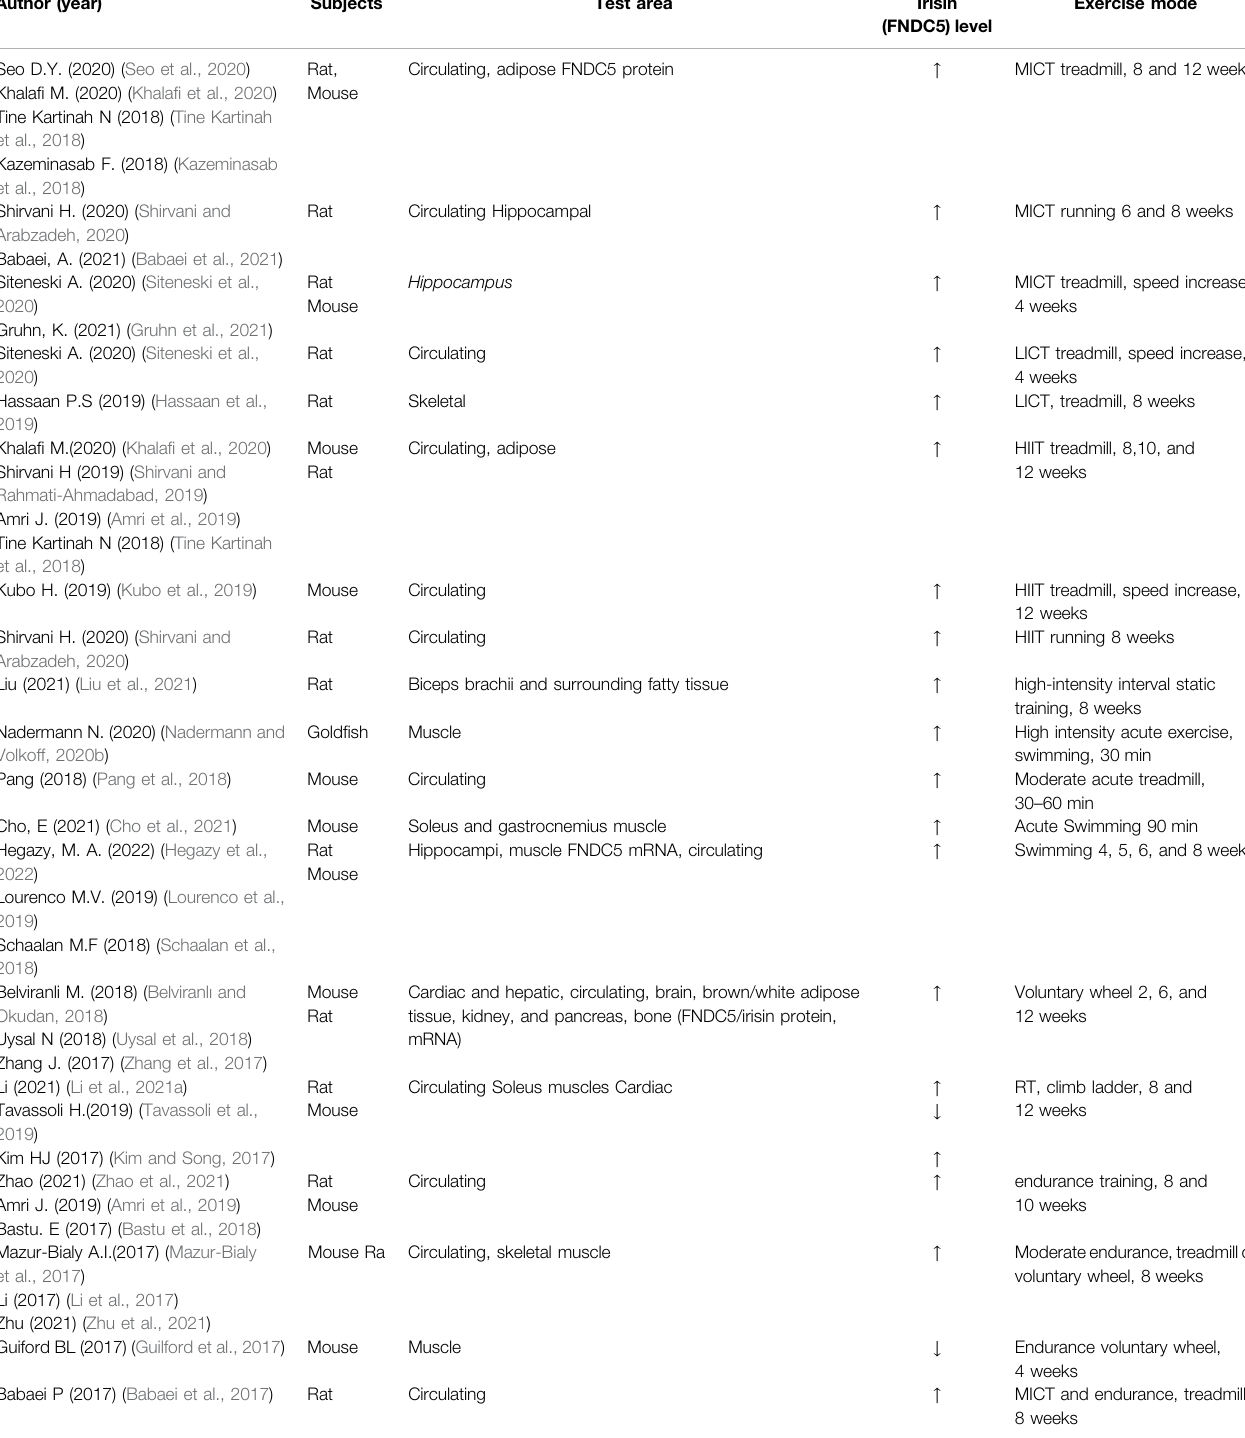
TABLE 1 | Study characteristics of animal experiments that explored the effects of exercise on circulating irisin